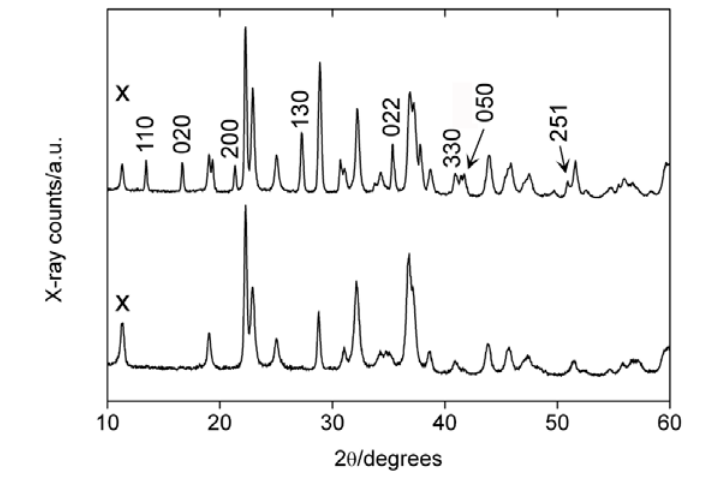
Figure 8 . XRD patterns of an as-prepared sample isolated after 20 hours (bottom) and after 30 hours (top). Only the reflections appearing between 20 and 30 hours of reaction 110 reflection, which is only found in the as- time are labeled. (x) denotes the γ -Zn(OH) 2 precipitated